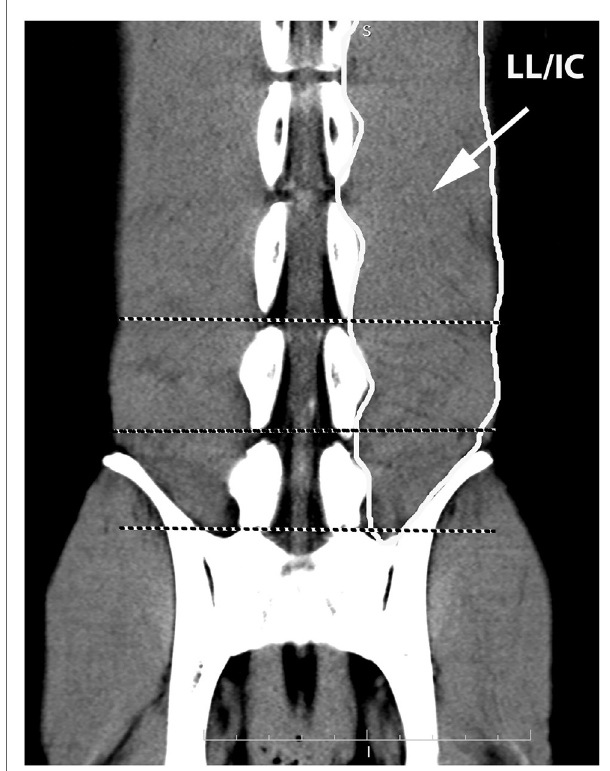
FIGURe 6 | dorsal oblique multiplanar Ct image at the level of the L5–s1 vertebral canal, illustrating margins of the combined longissimus lumborum/iliocostalis (LL/IC) muscle group . Notice that this muscle group tapers at the level of L7–S1.